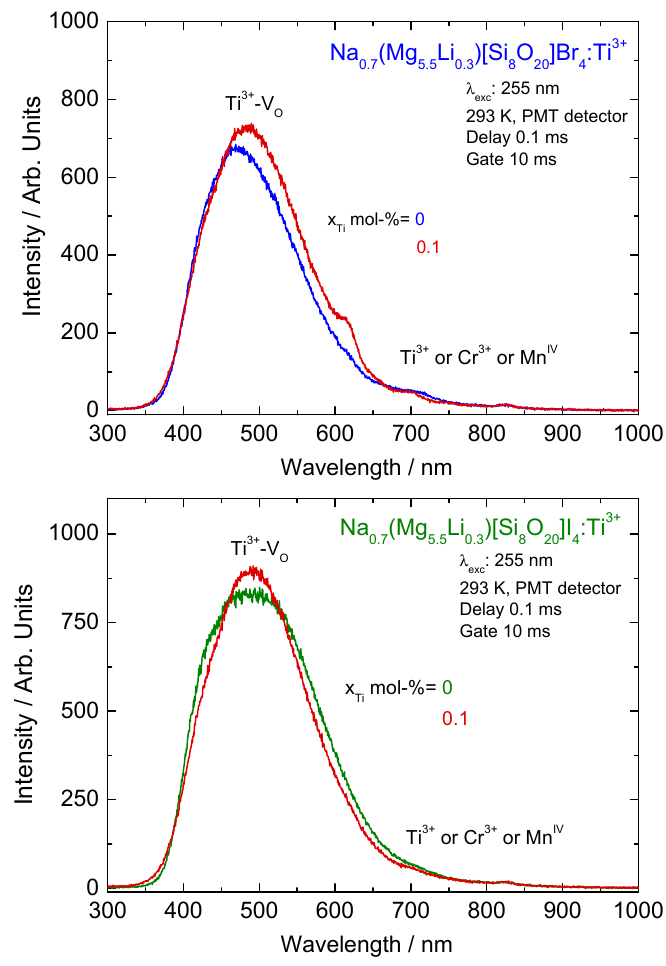
Figure A6. Emission spectra ( λ exc : 255 nm) of Br-Hec:Ti 3+ ( top ) and I-Hec:Ti 3+ ( bottom ), x Ti = 0.1 mol %.